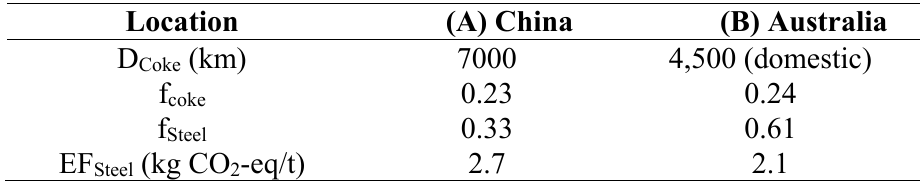
Table 6. Example radius of reduction.